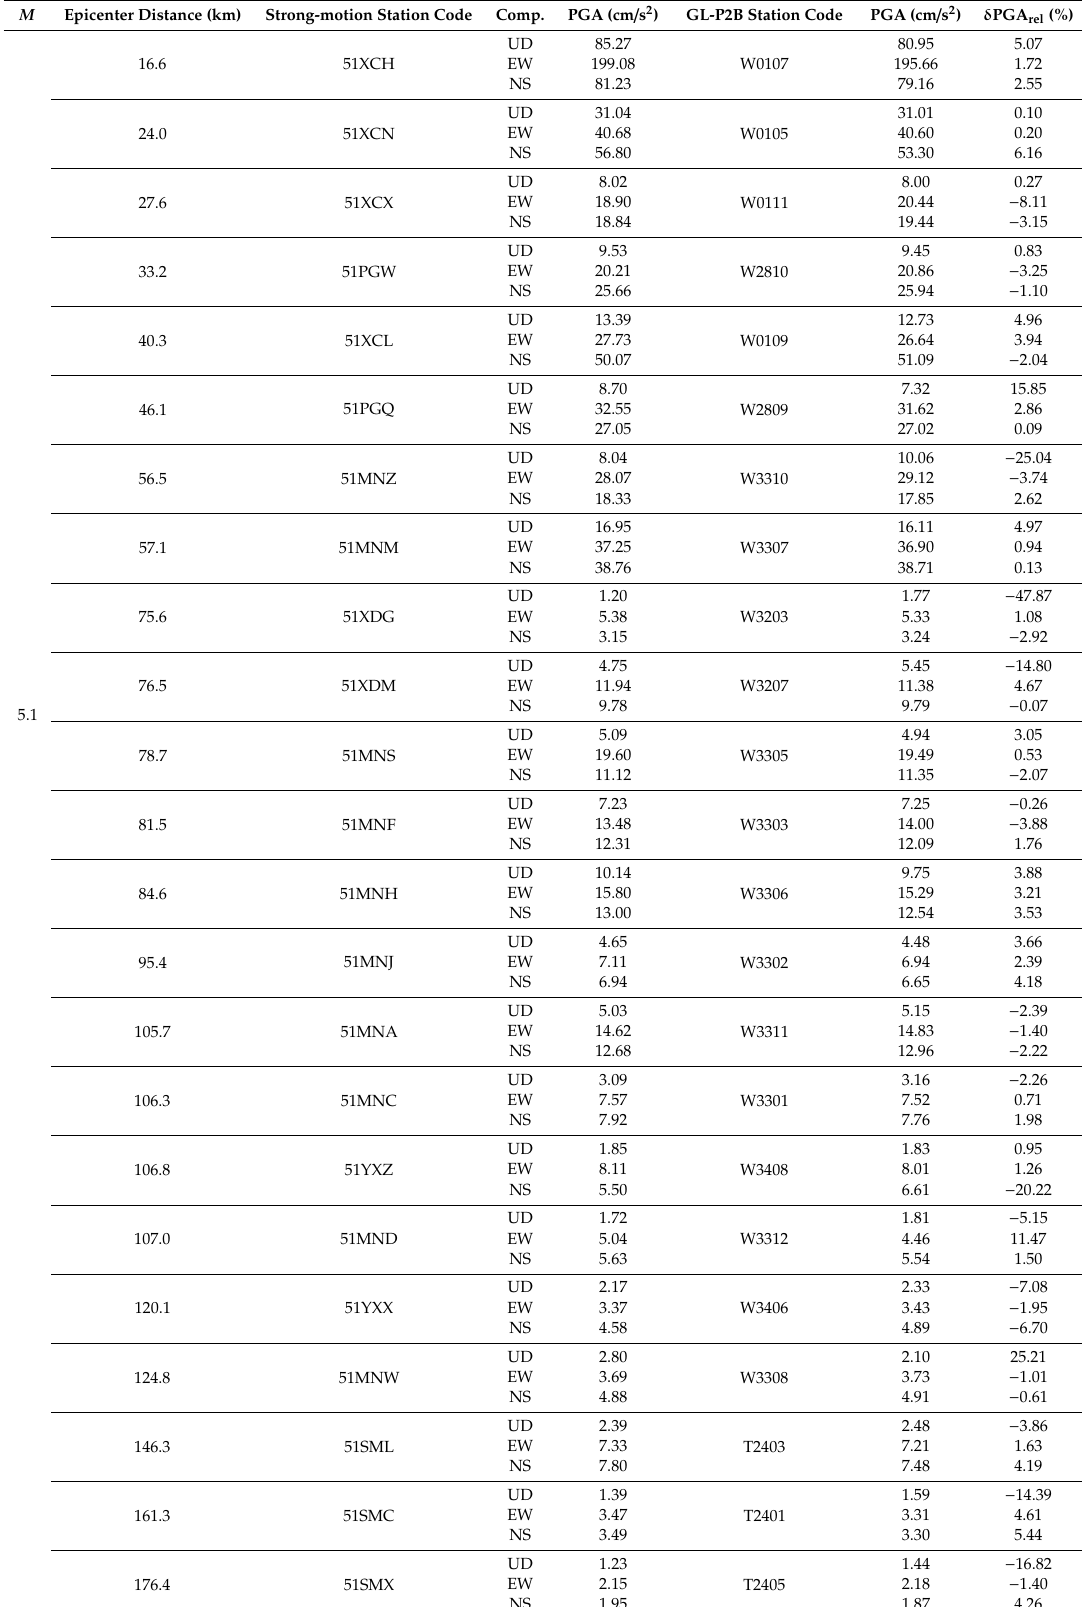
Table A1. Relative di ff erences of peak ground acceleration (PGA) recorded by collocated GL-P2B and traditional strong-motion stations for the two largest earthquakes with M 5.1 and M 4.3. M Epicenter Distance (km) Strong-motion Station Code Comp. PGA(cm / s 2